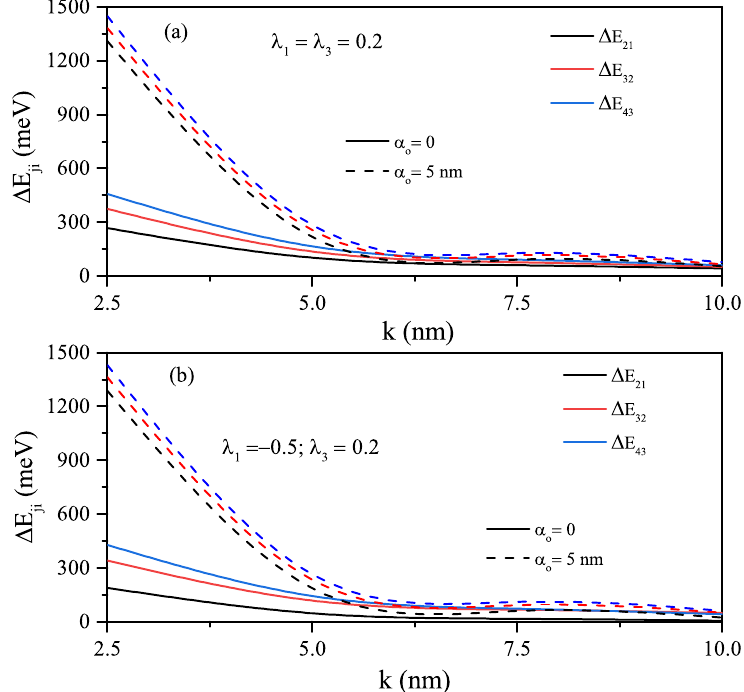
Figure 7. The variations of the energy differences between specified energy levels such as ∆ E 21 , ∆ E ∆ E 32 and 43 as a function of the width k -parameter: for the electron confined in the sextic single AHO potential ( λ 1 = λ 3 = 0.2 ) ( a ), and for the electron confined in the sextic double AHO potential ( λ = − 0.5, λ = 0.2 ) ( b ). Results are for α 3 1